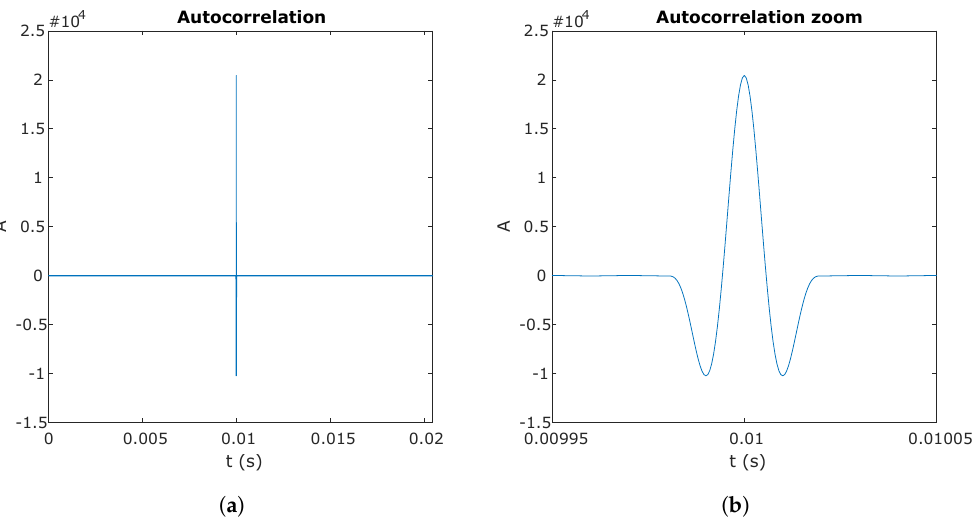
Figure 9. The 10-bit Kasami sequence autocorrelation function modulated in BPSK: ( a ) total size of the autocorrelation function; and ( b ) extended area centered on the correlation